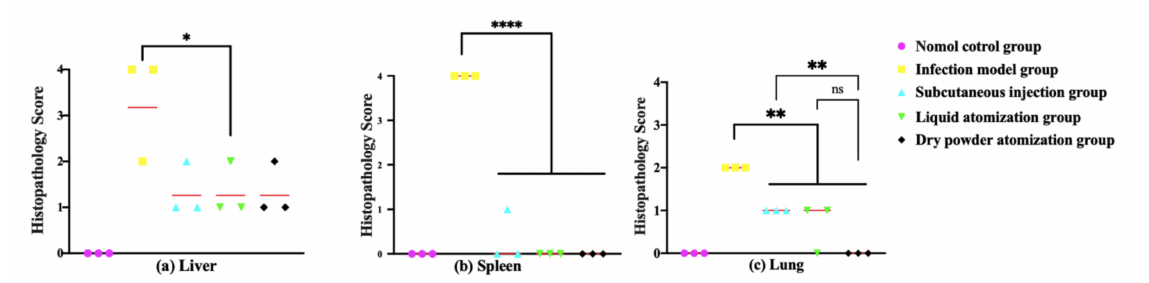
Figure 7. Pathological lesions in the tissues of mice euthanized 5 d after the Y. pestis strain 201 intratracheal challenge. Tissue from lungs, livers, and spleens were collected from three mice per group, fixed in formalin, embedded in paraffin, and stained with HE. Pathological scores of ( a ) liver tissue, ( b ) spleen tissue, and ( c ) lung tissue are presented. Tissue sections were evaluated by a trained pathologist according to the following scores: 0, no pathological lesions; 1, minimal; 2, mild; 3, moderate; and 4, severe. The degree of pathological lesions was related to the distribution and severity of the lesions as follows: (I) edema and (II) tissue parenchymatous lesions, such as congestion and hemorrhage. Data are expressed as the mean ± SD ( n = 3) for data collected from one representative experiment. * p < 0.05; ** p < 0.01; **** p <